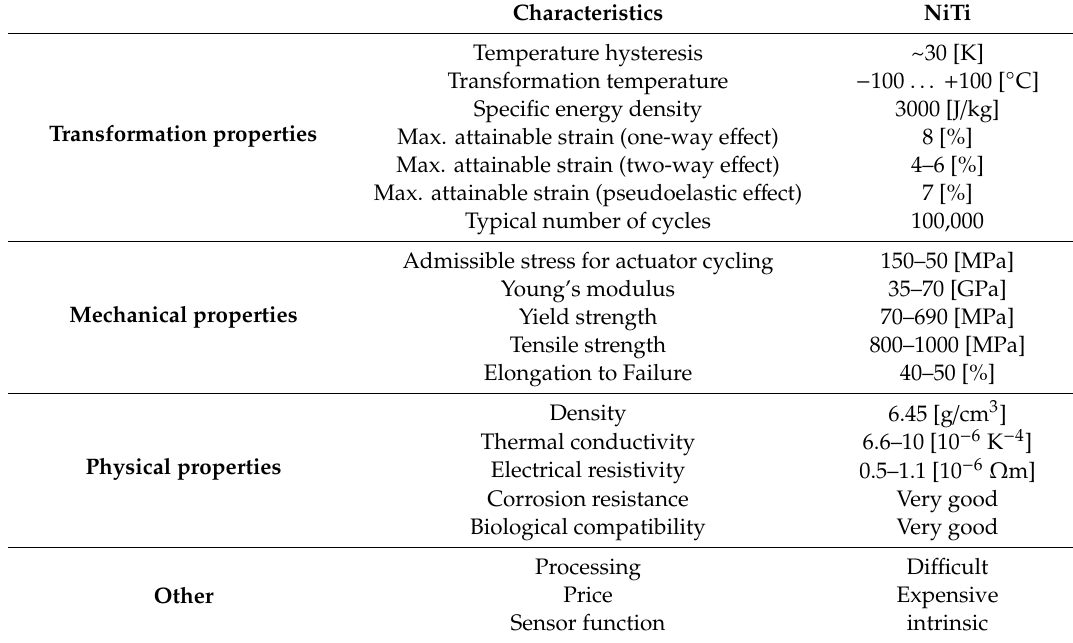
Table 1. Characteristics of NiTi- shape memory alloy (SMA)